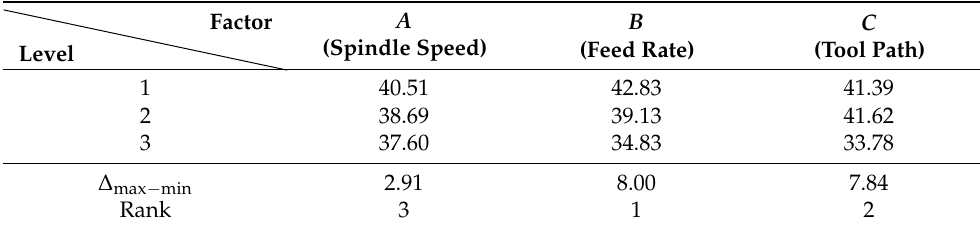
Table 10. Response table for S/N ratios for profile